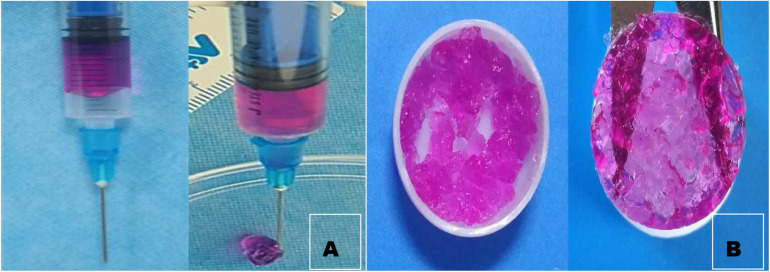
Injectability observation (A) and self-healing observation of hydrogel. (B) We can see from the graph that the broken hydrogel can self-heal one piece.